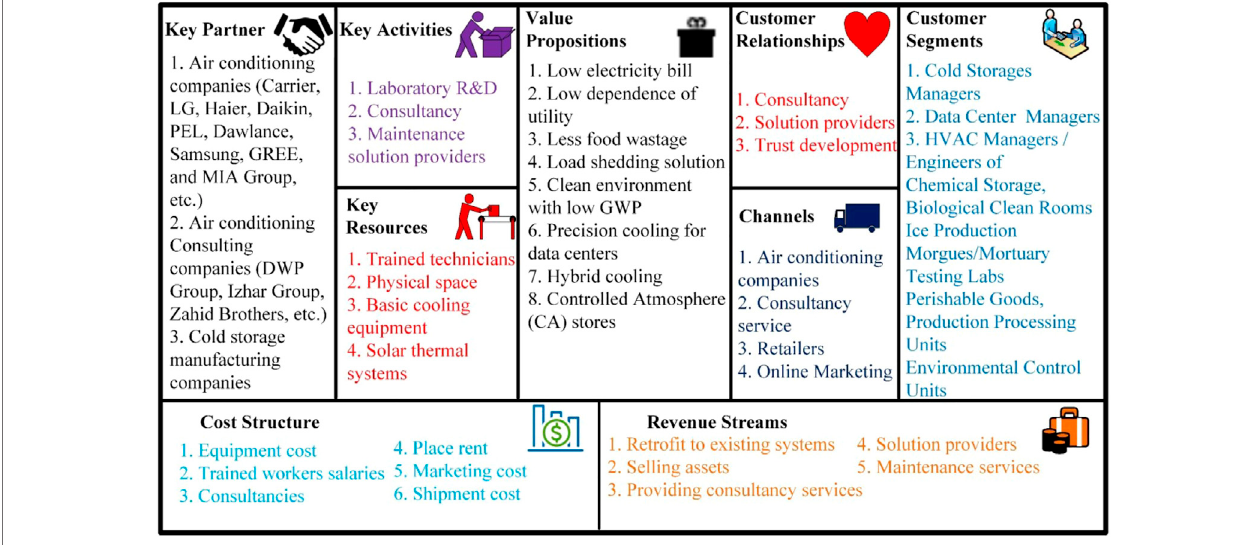
Frontiers in Energy Research |